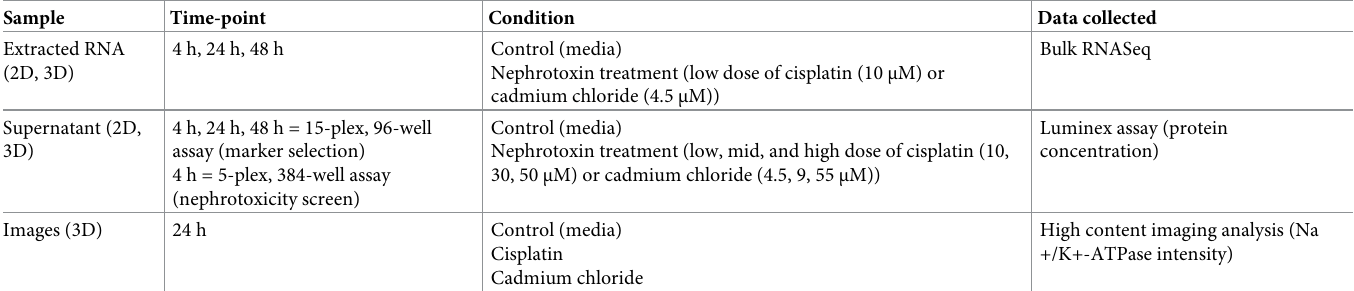
Table 3. Sample table and description of data